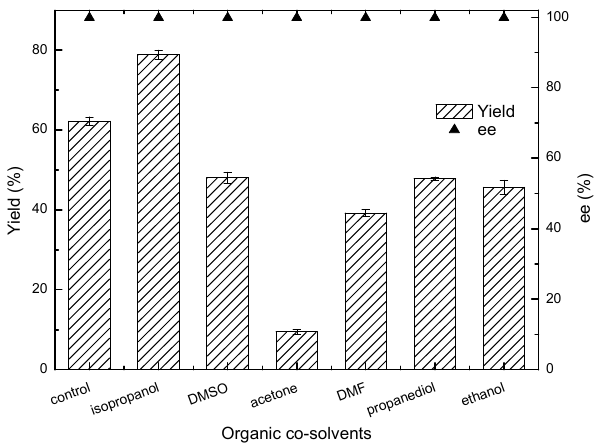
Figure 3. Effect of various organic cosolvents on the asymmetric reduction of 4-(trifluoromethyl)acetophenone.